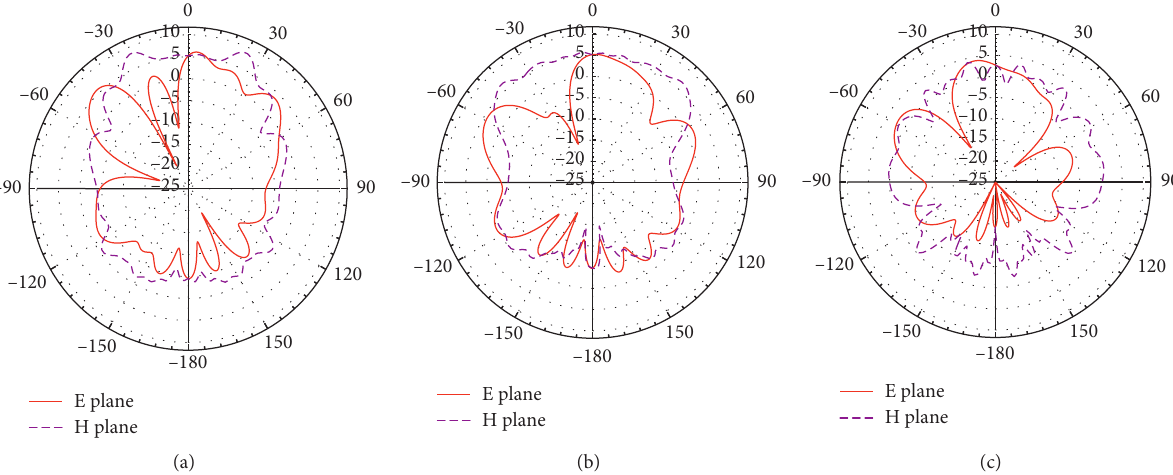
Figure 9: Radiation pattern of corporate-fed microstrip array antenna: (a) at 26.7 GHz, (b) at 28GHz, and (c) at